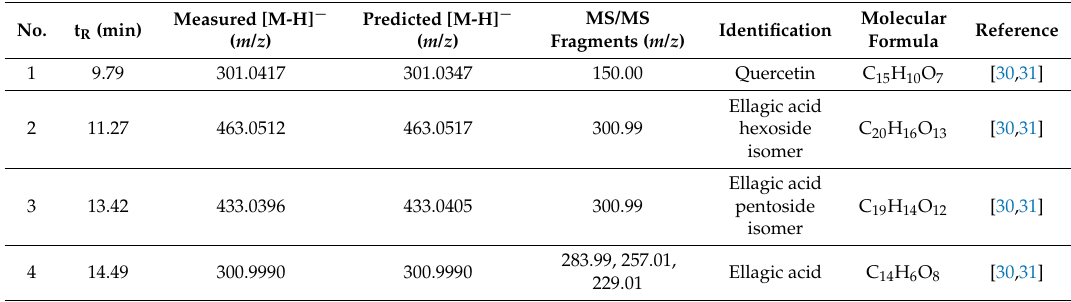
Table 2. Identification of fraction 9 using HPLC-ESI-IT-TOF-MS in the negative ion mode. No.